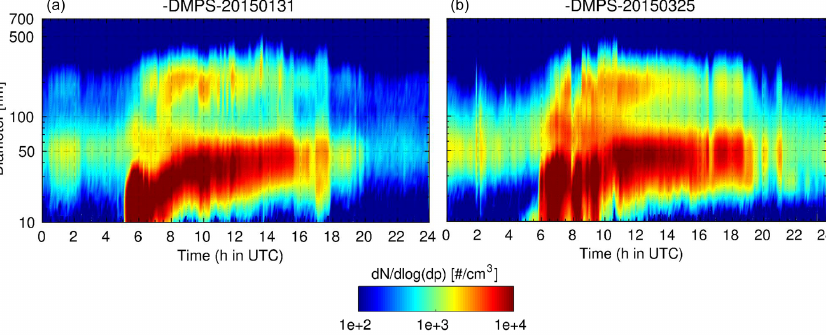
Figure A2. DMPS spectra for 31 January on the left and 25 March on the right. This is an evolution of the size distribution (left scale in nanometres) and of the aerosol concentration (colour scale) with time (from 00:00 to 24:00UTC).